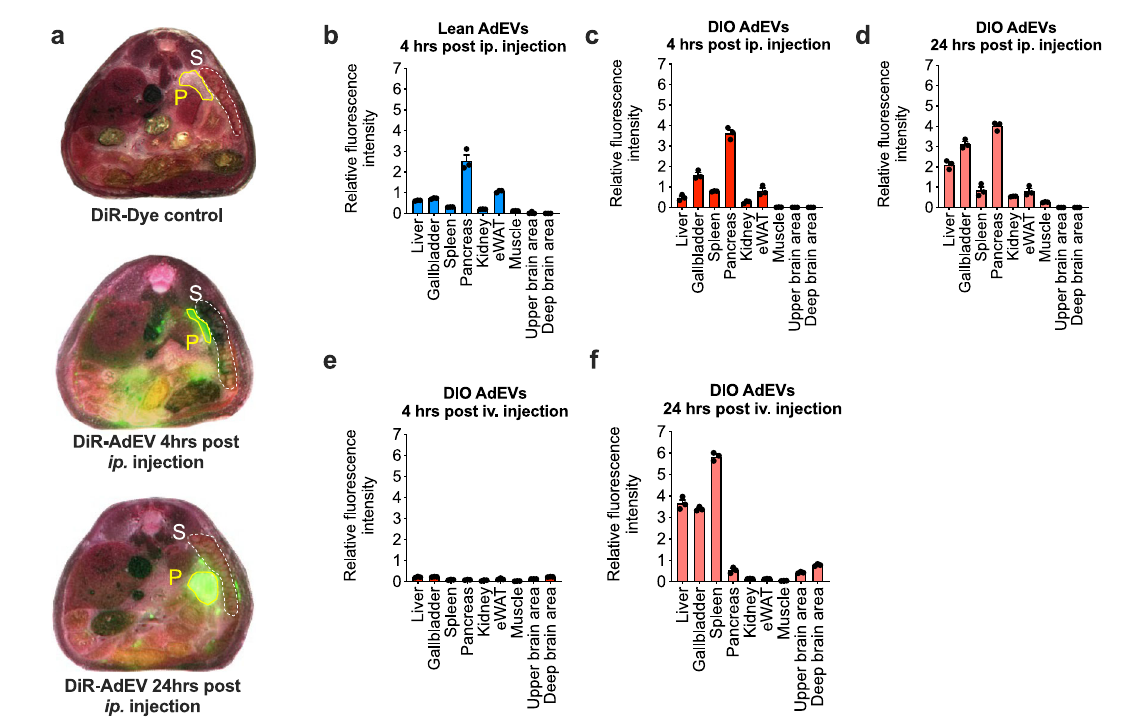
Fig. 5 | Biodistribution of AdEVs in mice. a Representative cross-sections of multiscale and multispectral images of whole cryo-sliced male lean C57BL/6J mice (11 to 16 weeks of age) after ip. injection with DiR vehicle control (upper panels) or DiR-labeled AdEVs DIO mice (middle and lower panel). Cross-sections show the pancreas (P) and spleen (S). b – f Relative quanti fi cations of fl uorescenceintensities